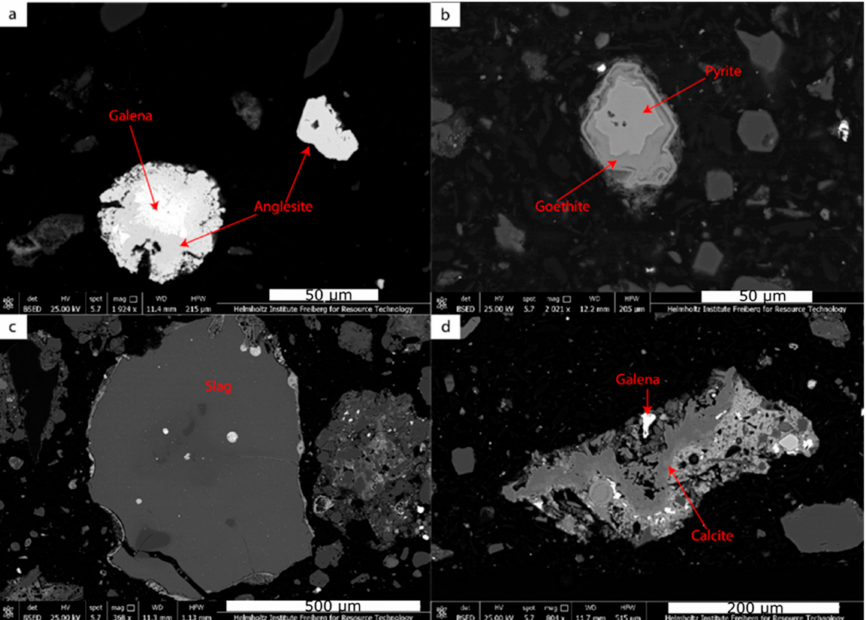
Figure 10. Photographs taken by SEM microscopy. ( a ) Composite grain of galena and anglesite. The lighter part of the grain is galena, while the darker grey part is anglesite. ( b ) Pyrite grain weathered to secondary phase (goethite). ( c ) Grain of slag with the inclusion of bright phases likely droplets of metallic phases. ( d ) Calcite grain agglomerated with grains of